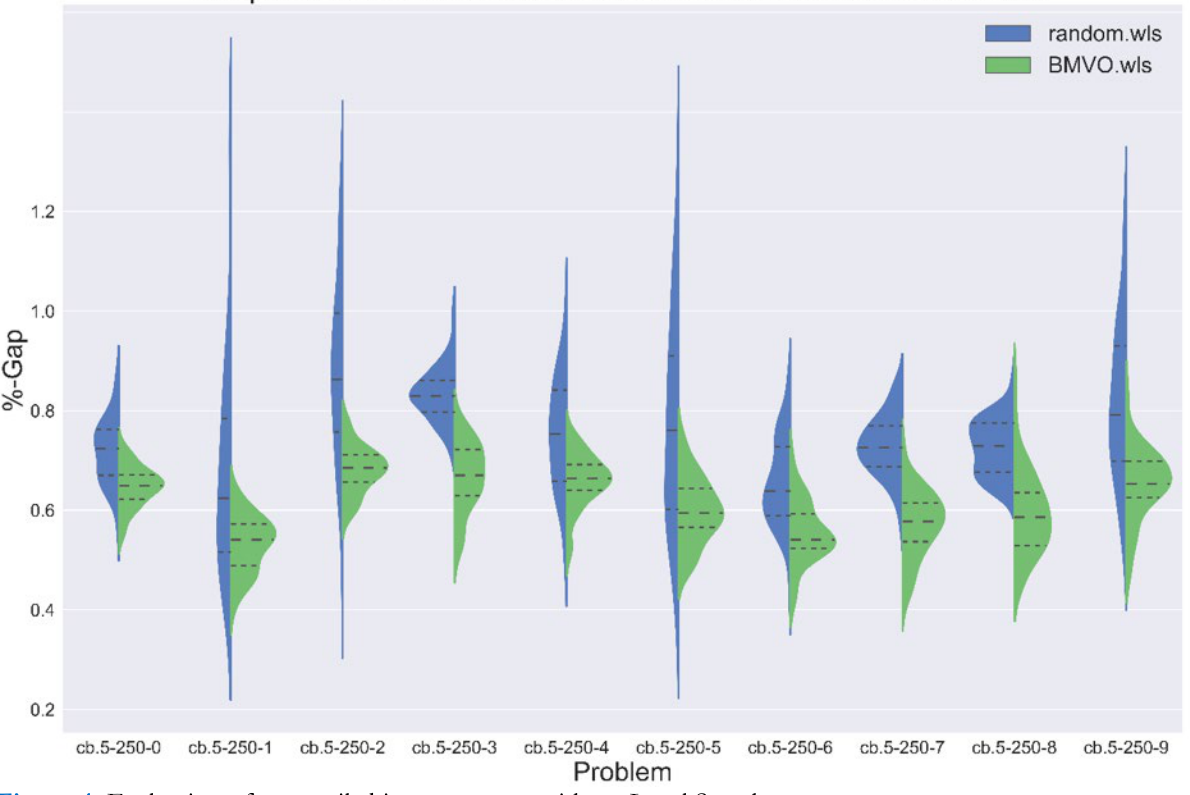
Figure 4. Evaluation of percentile binary operator without Local Search